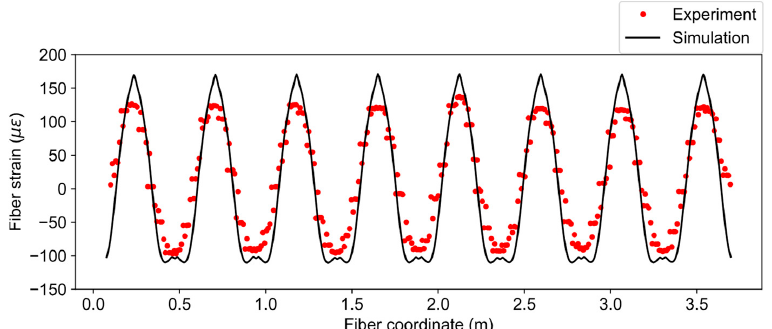
Figure 14. Comparison of fiber strains between simulation and experiment for u = 755 µ m.